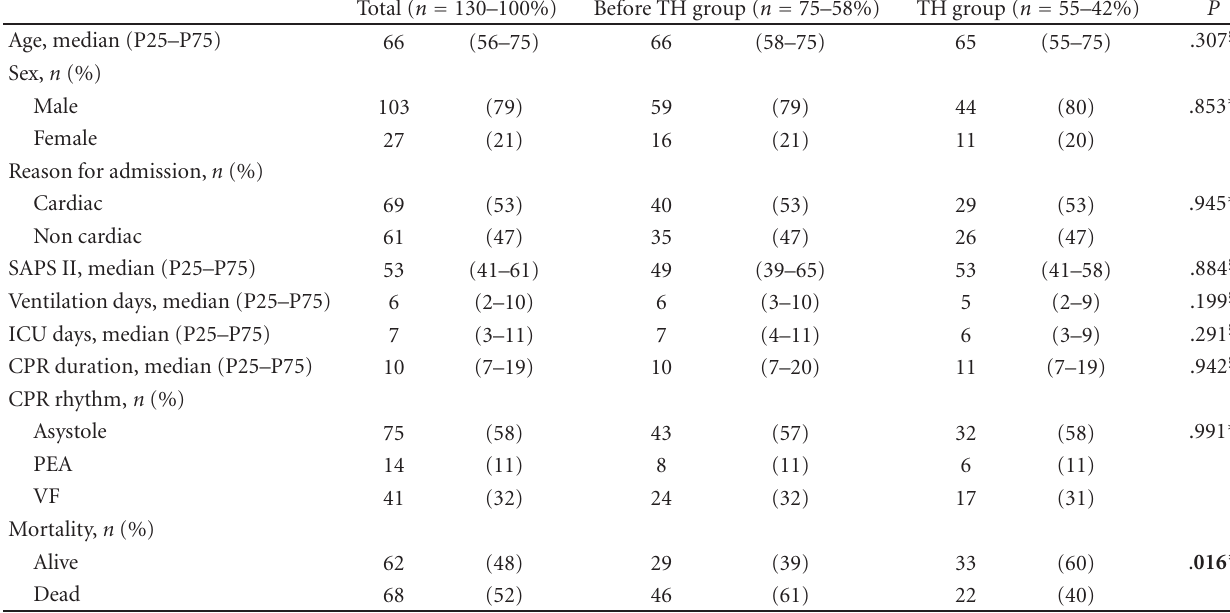
Table 1: Demographic, ICU cardiac arrest characteristics, and mortality of all included patients ( n =